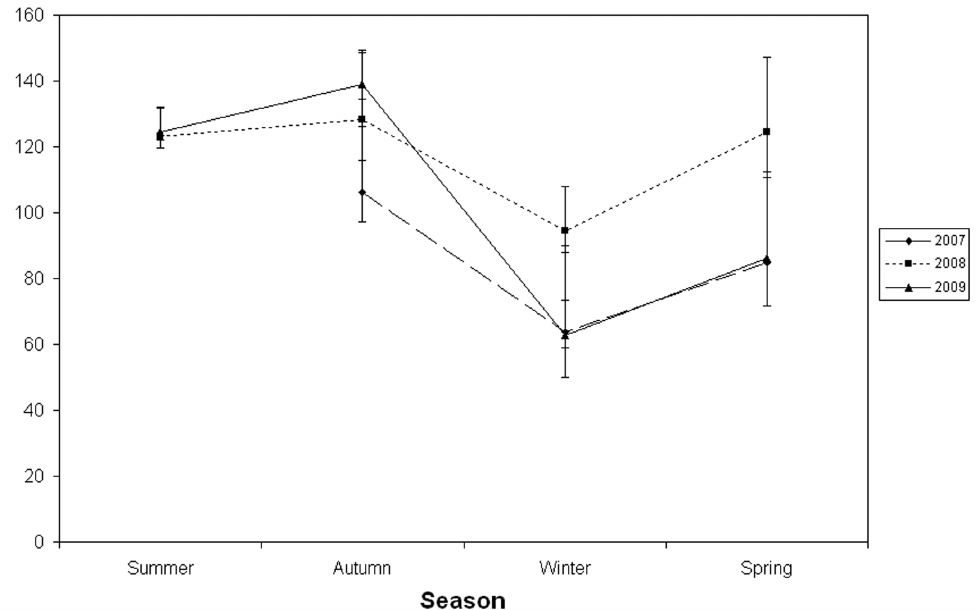
Figure 4. Seasonal abundance estimates of juvenile and adult (combined) bottlenose dolphins 2007-November 2009. 95% confidence intervals indicated by vertical